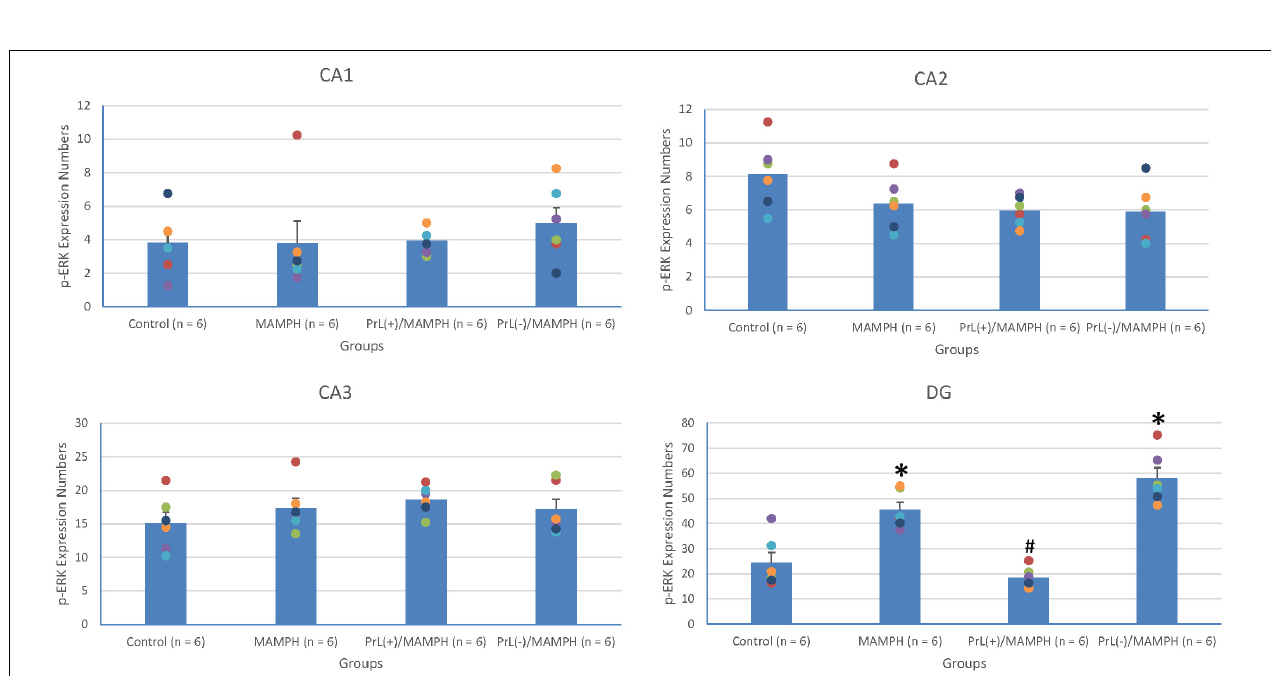
FIGURE 15 | MAMPH administrations were tested to label p-ERK expression in the CA1, CA2, CA3, and DG of the hippocampus for the control ( n = 6), MAMPH ( n = 6), PrL(+)/MAMPH ( n = 6), and PrL(–)/MAMPH groups ( n = 6) by injecting NMDA or saline into the PrL. PrL(+): Injection of a low concentration of NMDA to excite the PrL neurons; PrL(–): Injection of a high concentration of NMDA to destroy the PrL neurons. Differences in p-ERK expression levels in the CA1, CA2, CA3, and DG among all groups were analyzed by one-way ANOVA, followed by Tukey’s post hoc test if a significant difference was appeared among groups. ∗ p < 0.05 indicates significant differences compared with the control group; # p < 0.05 indicates significant differences compared with the MAMPH group.